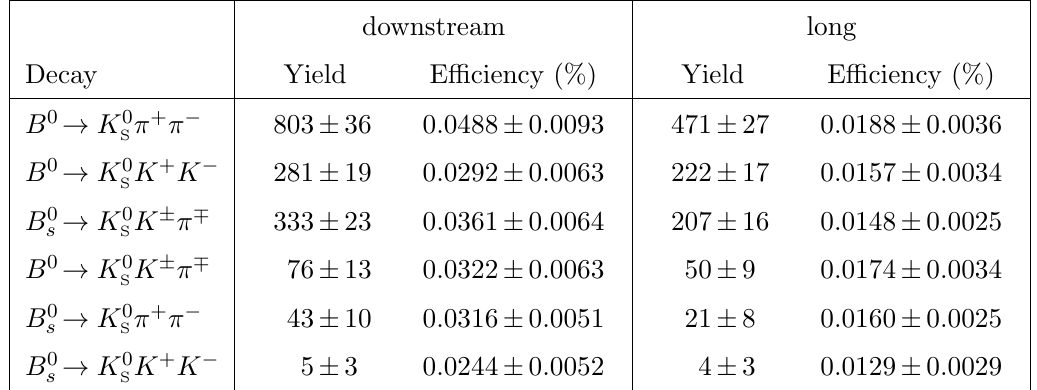
Table 3 . Signal yields obtained for the 2011 category from the simultaneous (cid:12)t to the data. The yields shown are those obtained when (cid:12)tting the data sample selected using the BDT optimisation chosen for the given decay mode. The uncertainties are statistical only. The average selection e(cid:14)ciencies, described in section 5, are also shown for each decay mode together with the corre- sponding total uncertainty due to the limited simulation sample size and systematic e(cid:11)ects in their determination.